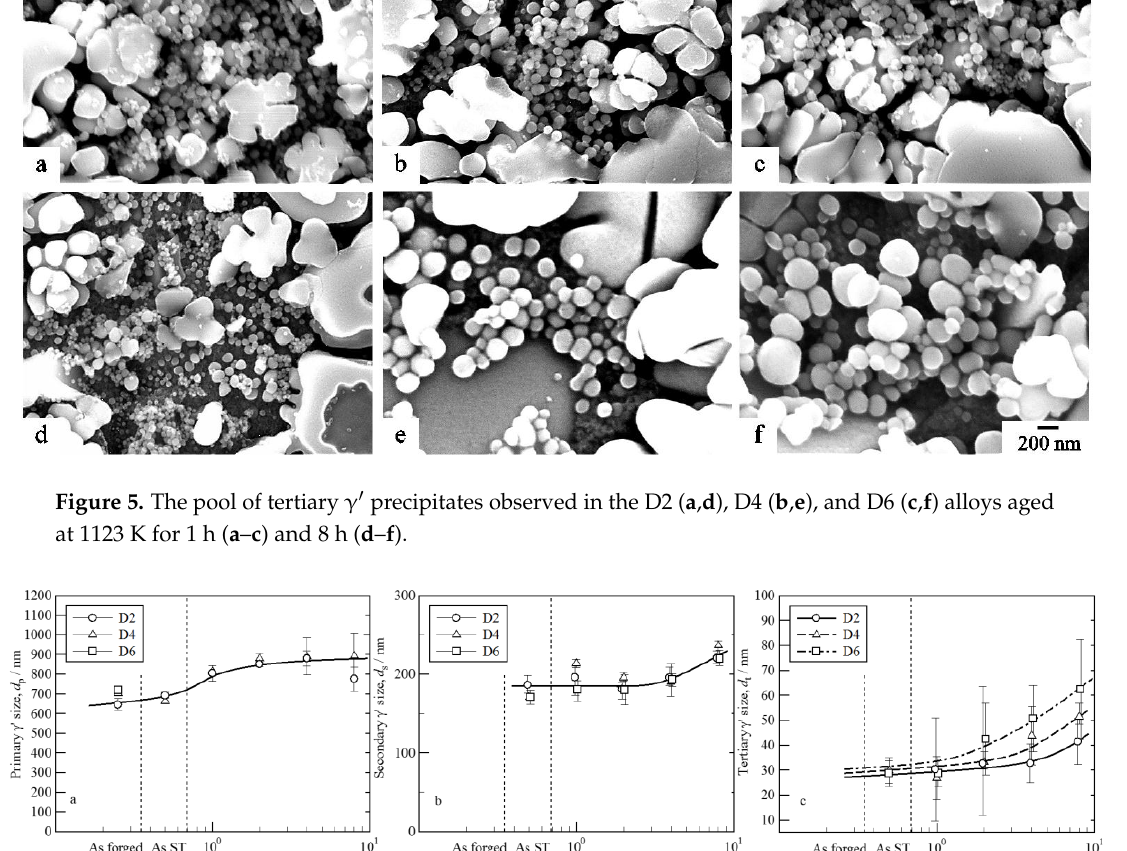
Figure 5. The pool of tertiary γ ′ precipitates observed in the D2 ( a , d ), D4 ( b , e ), and D6 ( c , f ) alloys aged at 1123 K for 1 h ( a – c ) and 8 h ( d – f ).